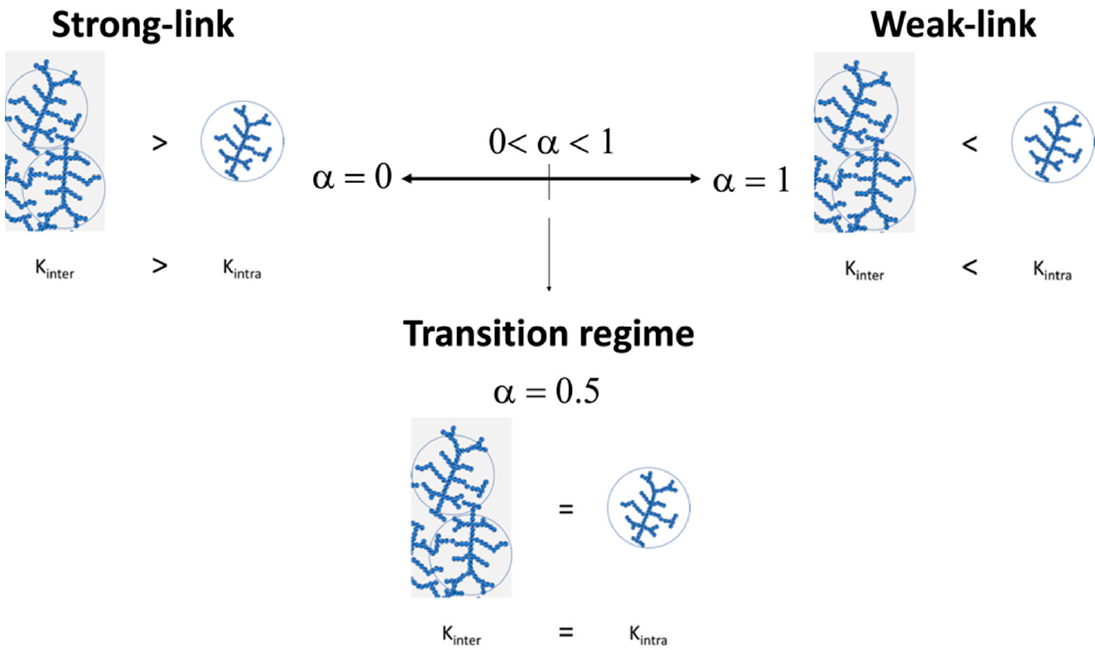
Scheme 4. Representation of the physical meaning of α parameter where both the strong and weak- link regimes as well as the transition regime are